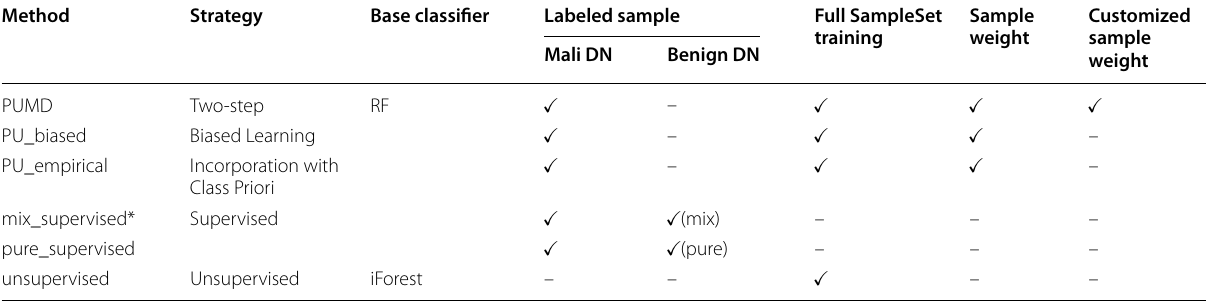
Table 10 PUMD and multiple comparison algorithms analysis